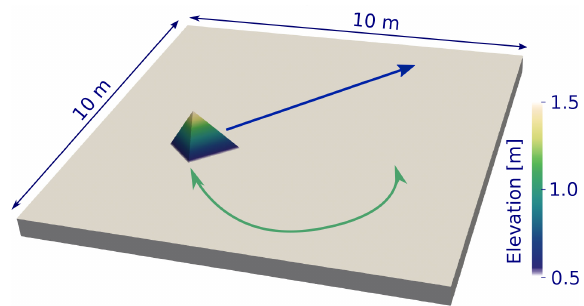
Figure 2. Initial 3D geometry for benchmark tests with surface el- evation in colour and arrows indicating the direction of movement for the pyramid translation test in blue and for the swirling flow test in